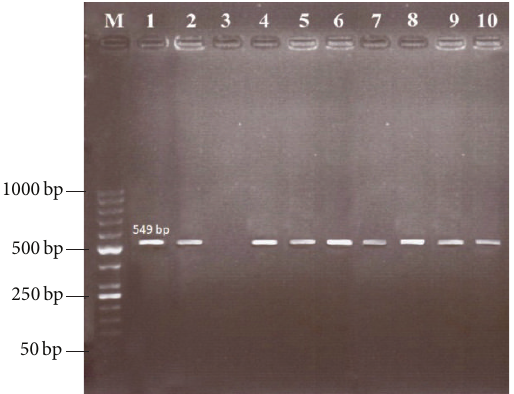
Figure 1: PCR products amplified using B. ovis -specific primers.